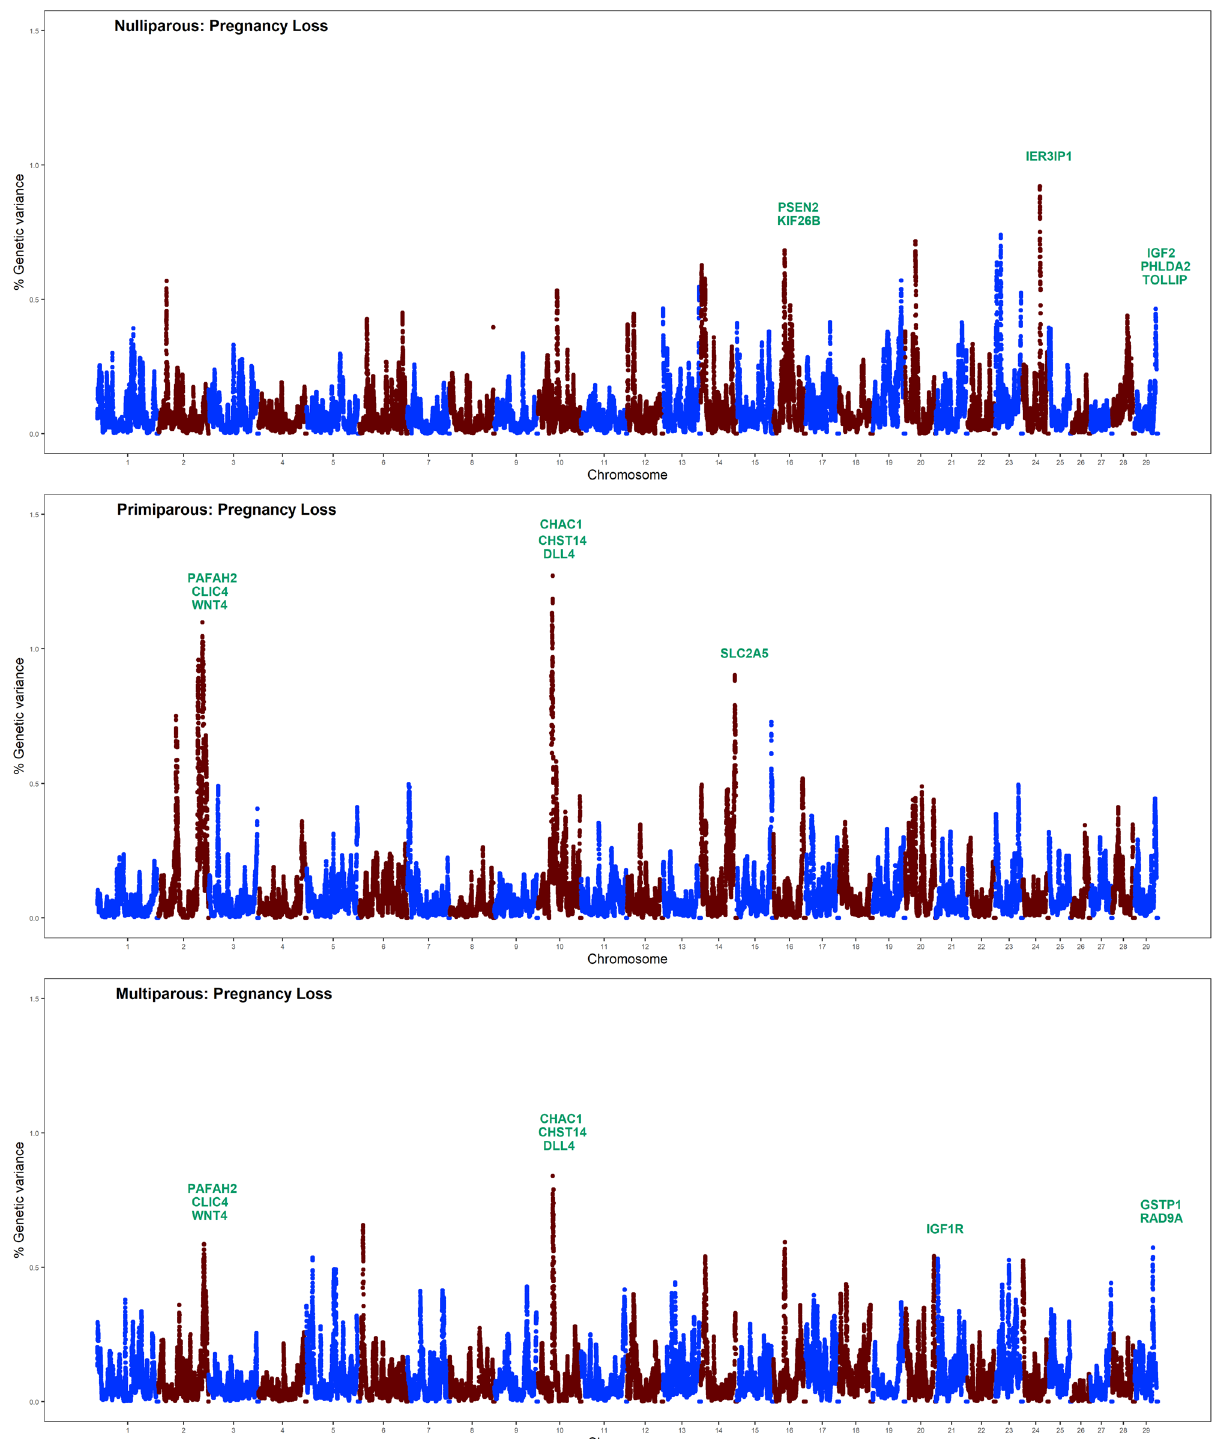
Figure 1. Whole-genome scans for pregnancy loss across the first three parities in Holstein dairy cows: Percentage of additive genetic variance explained by 2.0 Mb single nucleotide polymorphism (SNP)-windows across the genome. Genes directly implicated in pregnancy maintenance and fetal growth are highlighted in